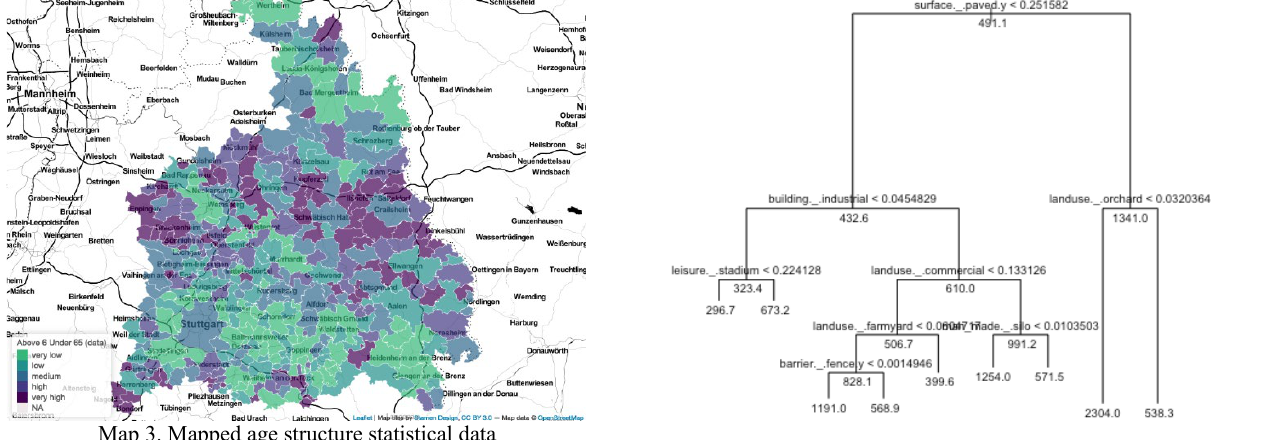
Figure 4. Regression tree business tax per capita 3.3.2